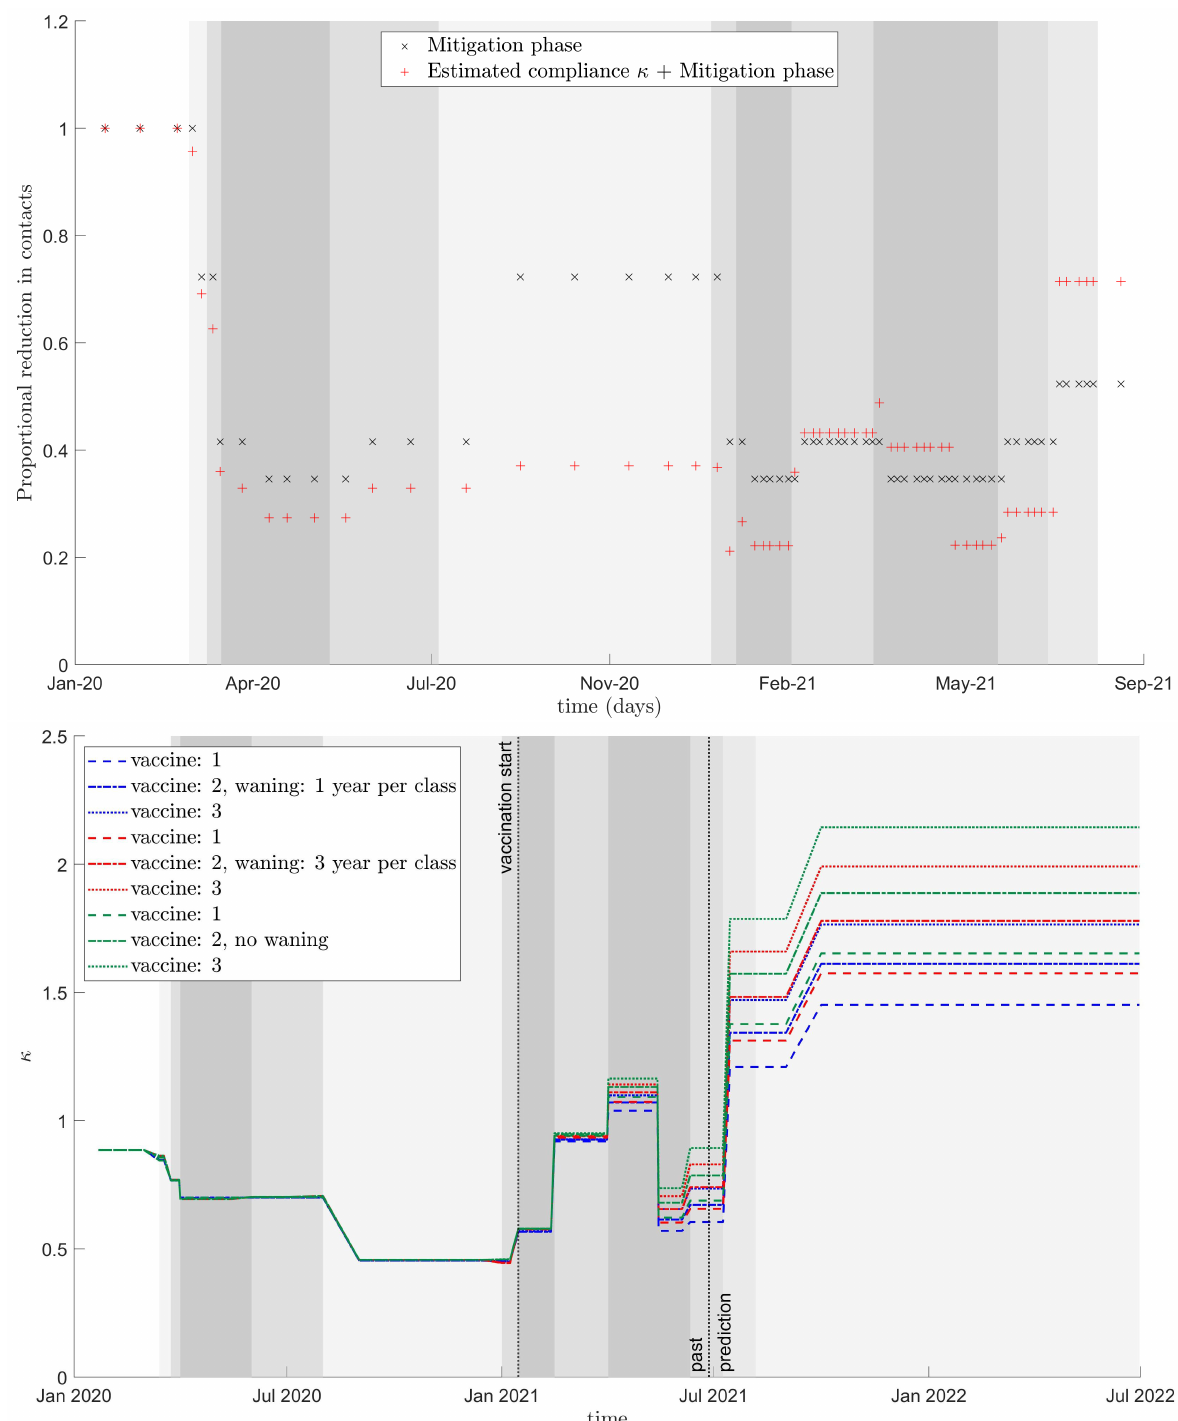
Figure A2. Changes in contact levels over time. (top panel) Average overall contacts compared to no mitigation from modified contact matrices (x’s) plus parameter κ (red +’s). (bottom panel) Value of parameter κ from the model fit (before black vertical line), and into the future (after black vertical line). A 20% increase in κ in September 2021 is shown here. In both panels, mitigation phases are shown with background shading where darker shading represents more restrictive mitigation, see Tables A3 and A4 for